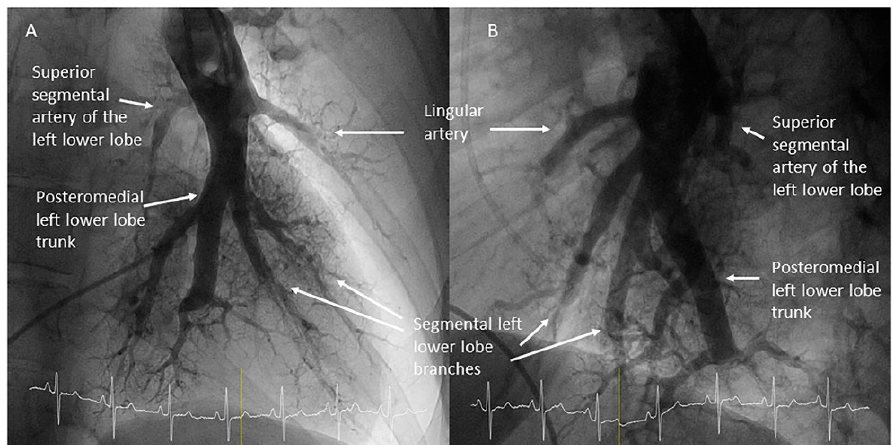
Figure 19. Left lower lobe branches. Posteromedial trunk (A7/10) and two independent basal segmental branches (A8 and A9): ( A ) anteroposterior and ( B ) lateral views.